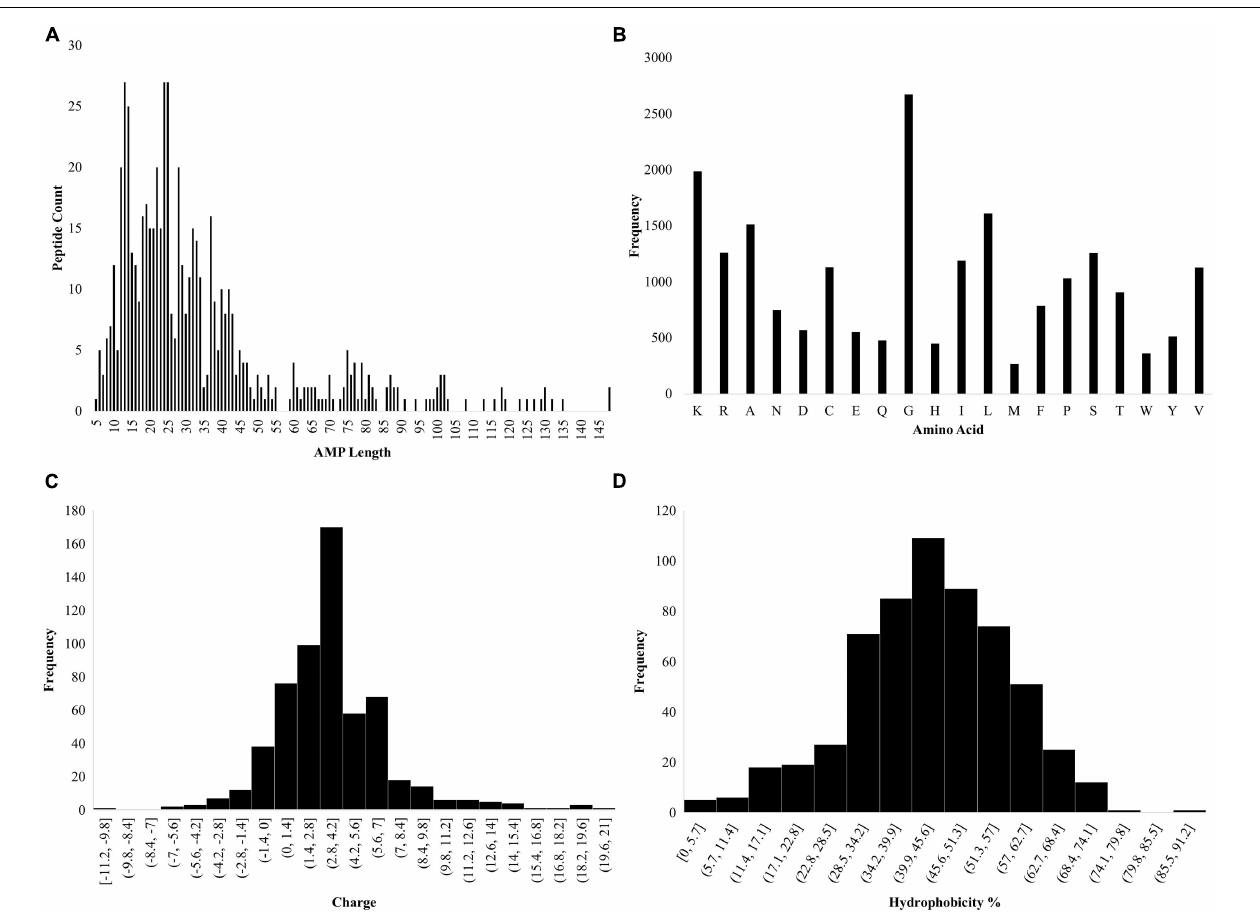
FIGURE 2 | Statistics of AMP properties obtained from APD3. (A) Lengths of AMPs in Dataset 1. (B) Frequency of total amino acid residues in Dataset 1. (C) Charge of the AMPs in Dataset 1. (D) Hydrophobicity percentage of AMPs in Dataset 1 [hydrophobicity was calculated as a percentage of hydrophobic amino acids, based on the Kyte and Doolittle scale (Kyte and Doolittle, 1982) divided by the total number of amino acids per